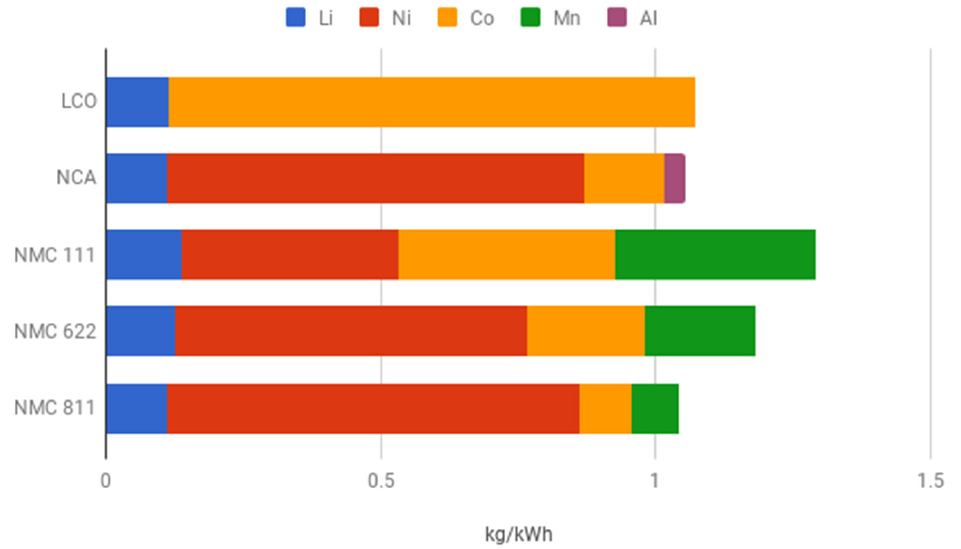
Figure 2. Comparison of different battery chemistries, LCO, NCA, and NMC, and their material/elemental composition, according to [6].